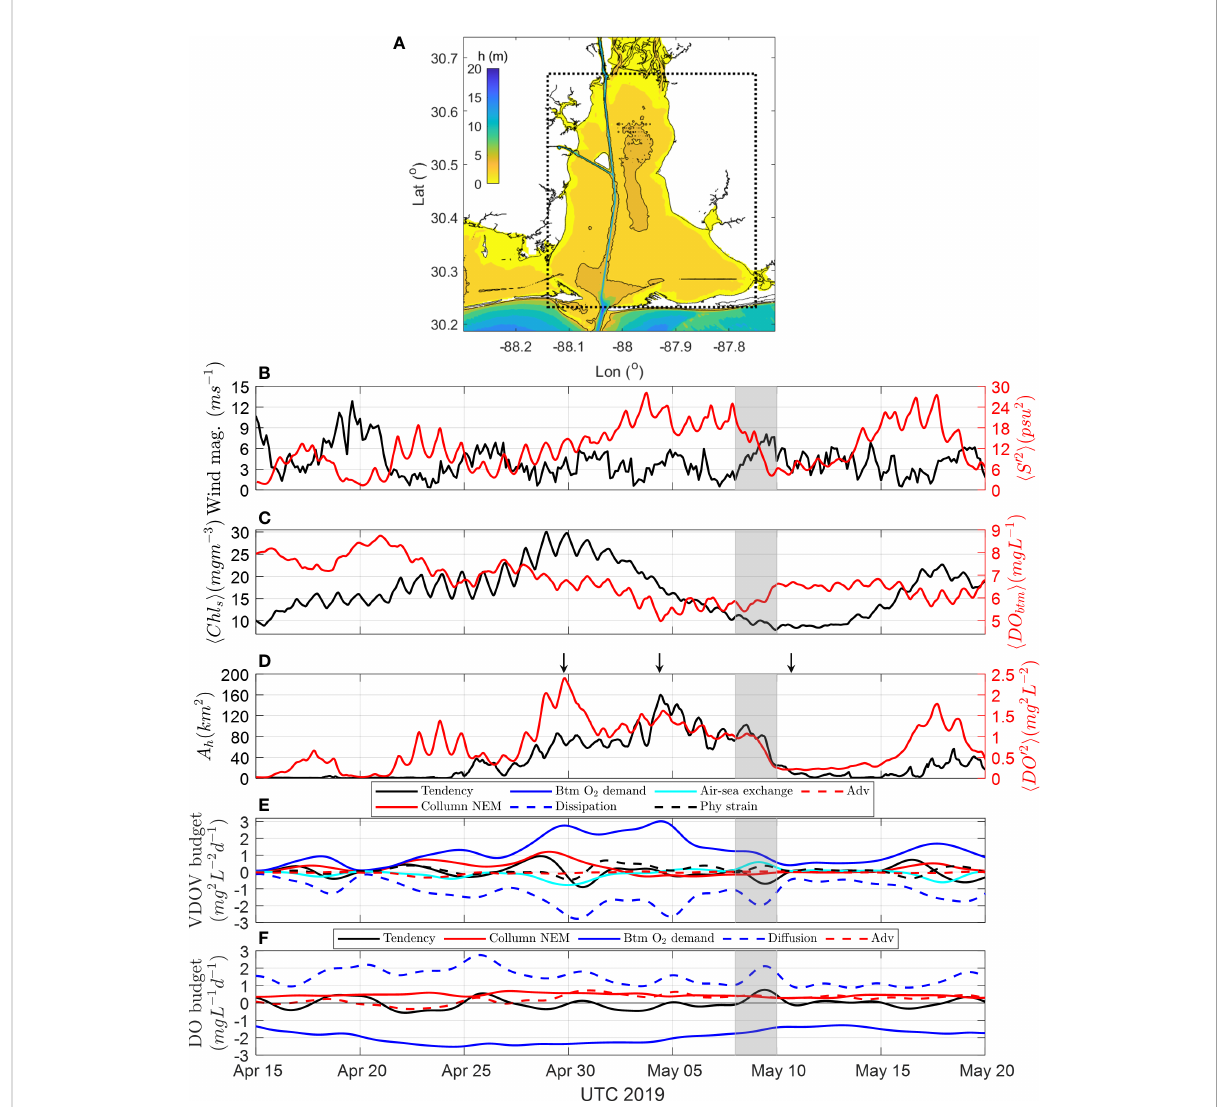
FIGURE 7 Evolution of wind, strati fi cation, phytoplankton bloom and hypoxia. (A) Region for taking spatial average. (B) 3-hour averaged raw wind speed in the center of Mobile Bay from NARR and volume averaged vertical salinity variance ( S ′ 2 ). (C) Spatially averaged surface chlorophyll concentration ( Chl ) and bottom DO ( DO b ). (D) Hypoxia area A h , and volume averaged DO ′ 2 . Arrows denote the time points of Figure 8. (E) Volume averaged VDOV budget terms. Positive terms denote mechanisms creating oxygen variance, while negative terms denote mechanisms destructing oxygen variance. (F) Volume averaged DO budget terms in the lower 1/3 water column. Positive terms denote mechanisms increase DO in lower water column, and negative terms denote mechanisms decreasing DO in lower water column. A low-pass 48-hr Lanczos fi lter was applied to both VDOV and DO budget terms shown in panels (E, F) . Grey boxes in all panels denote a southeast wind event during May